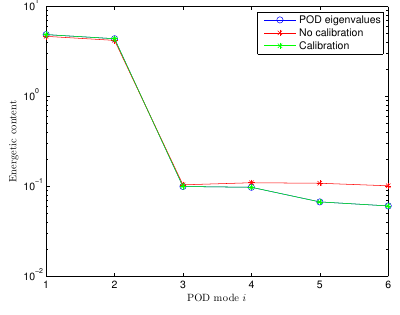
Figure 7. Comparison between the modal energetic contents obtained before and after calibration. The POD eigenvalues are reported for reference. The POD ROM is calibrated by minimizing J α , with the determination of all the coefficients (constant, linear and quadratic). The regularization parameter α is determined at the inflection point of the L-curve.